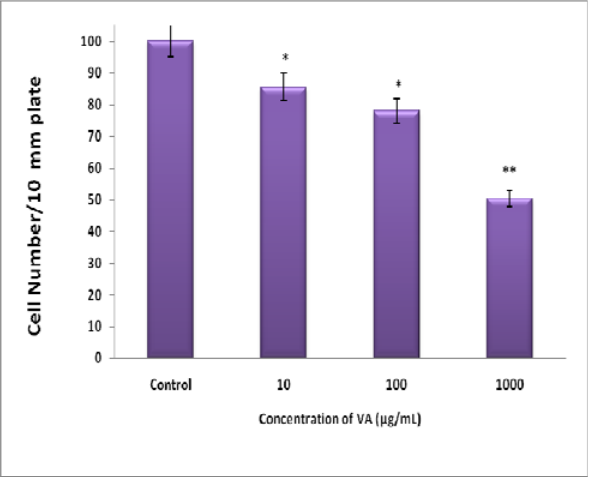
Figure 1 : Inhibition of BT-549 Cell Proliferation by Aqueous VA Extracts- cells at logarithmic growth phase were treated with various concentrations (0-1000µg/mL) of VA for 24 h; followed by cell counts using a hemacytometer. Each data point represents the mean of three independent experiments. *P<0.05; **P<0.005. by DNA synthesis assay as DNA synthesis is a others [28-29] have previously determined that the doubling time for these cells is less than 24